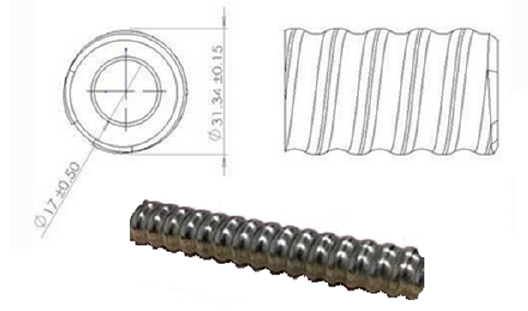
Figure 4. Concrete prismatic cube.